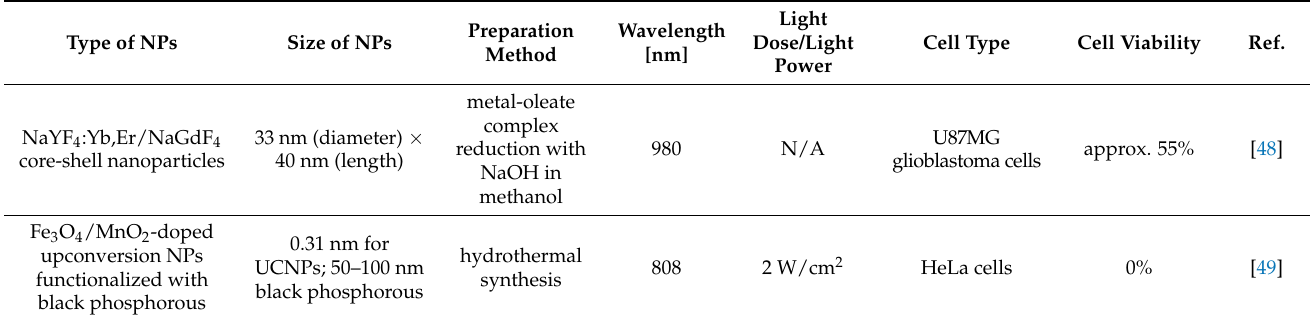
Table 3. Summary of the data presented in Section 2.3.